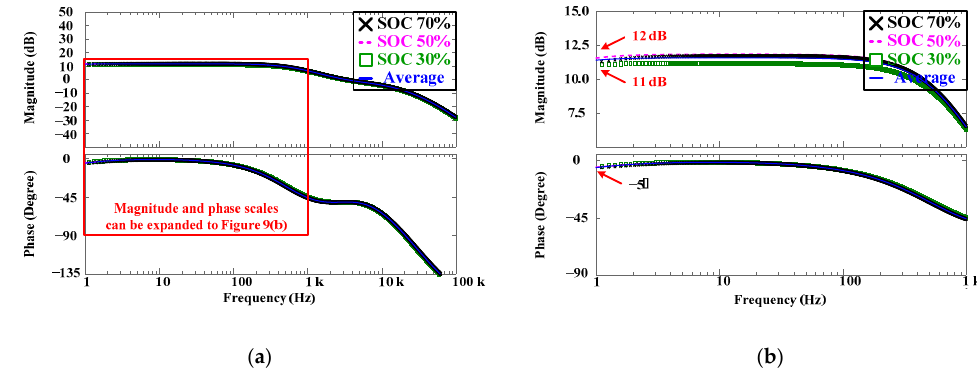
Figure 9. Different SOCs of G ov ( s ). ( a ) Using the three SOCs and the average parameters. ( b ) Expanding scale from Figure 9a.